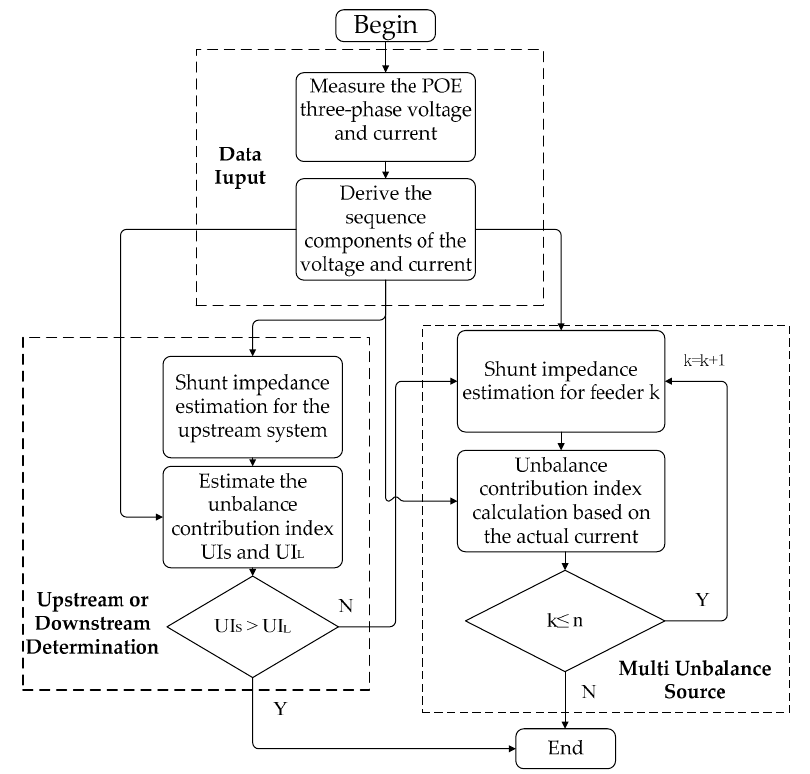
Figure 5. Flowchart for the unbalance contribution determination method. POE: point of evaluation; and UI: unbalance